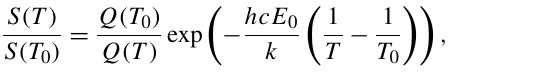
Fig. 5, the bias metrics for the systematic error scenarios de- scribed in Sect. 2.5 are summarised in Table 2